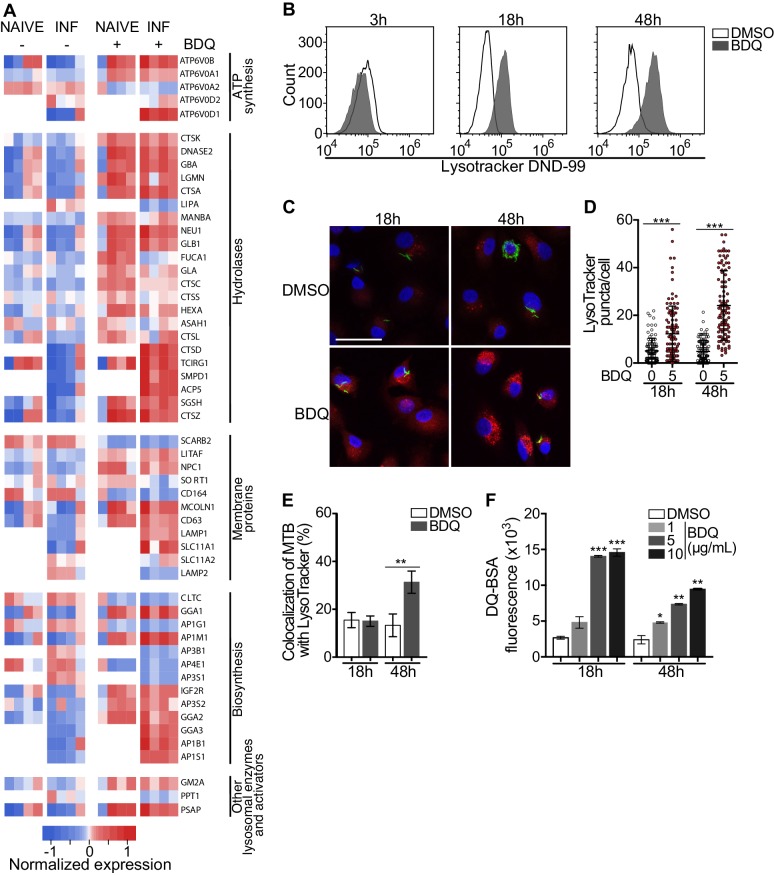
BDQ activates the lysosomal pathway in human MTB-infected macrophages.(A) Heatmap showing differential expression of genes included in the Lysosome KEGG category (p-value<0.05). Each column corresponds to one donor. Data were normalized to determine the log ratio with respect to the median expression of each gene. (B) Macrophages were infected with BDQr-MTB expressing the GFP protein and incubated with BDQ (5 μg/mL) for 3 hr, 18 hr and 48 hr. Acid organelles were then labeled with 100 nM LysoTracker DND-99 for 1 hr. The fluorescence intensity was quantified by flow cytometry. (C–E) Cells were infected with GFP expressing BDQr-MTB (green) and treated with BDQ (5 μg/mL). After 18 hr and 48 hr of treatment, cells were labelled with LysoTracker (red) and fluorescence was analyzed by confocal microscopy. DAPI (blue) was used to visualize nuclei (scale bar: 10 μm). The quantification of LysoTracker staining and the percentage of LysoTracker-positive MTB phagosomes were performed using Icy software. (F) Macrophages were activated with heat-killed MTB and treated with BDQ for 18 hr and 48 hr. Cells were then incubated with DQ-Green BSA. Fluorescence was quantified by flow cytometry. Significant differences between BDQ treatment and control (DMSO) are indicated by an asterisk. One representative experiment (of at least three) is shown. Error bars represent the mean ± SD. *p<0.05, **p<0.01, ***p<0.001.